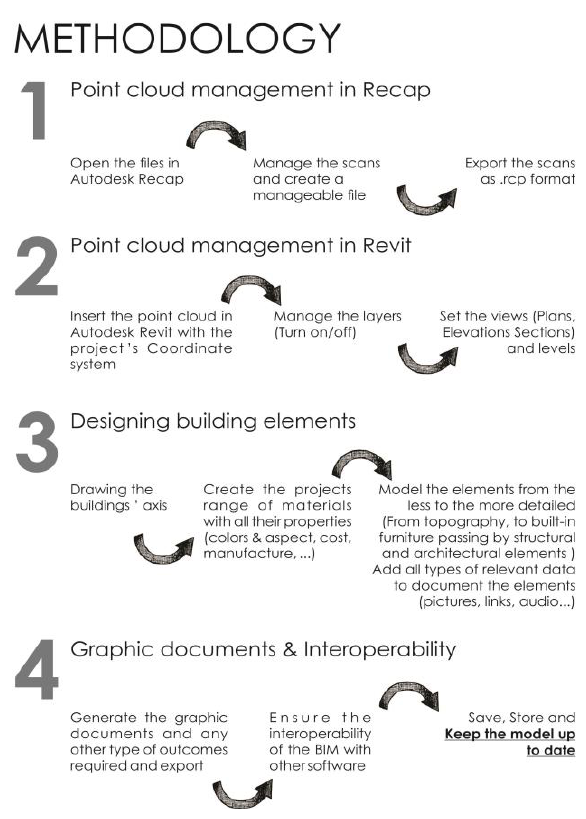
Figure 9. Scheme of the Building Information Modelling (BIM) methodology for the Strutt House, by Pierre Jouan.